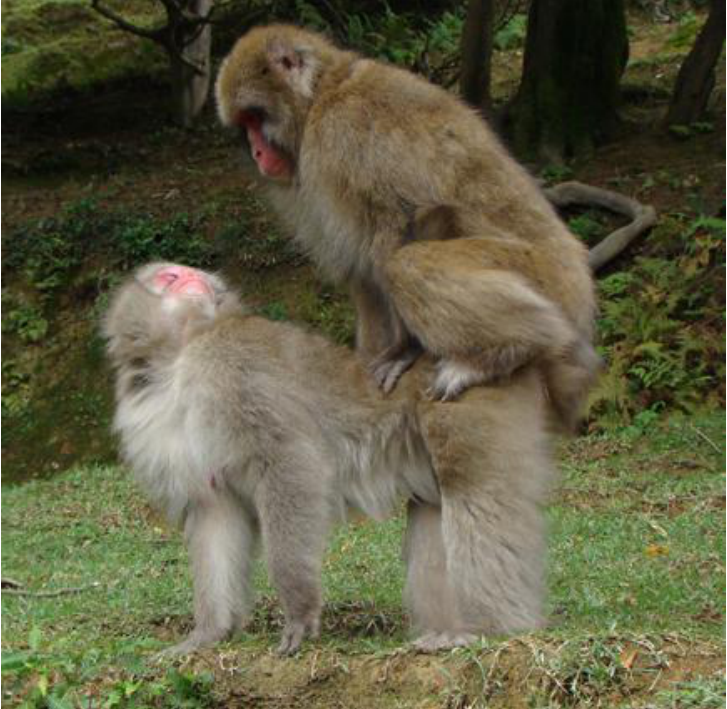
Figure 4 . Sitting mount posture during FFM at Arashiyama (photo by J.-B.